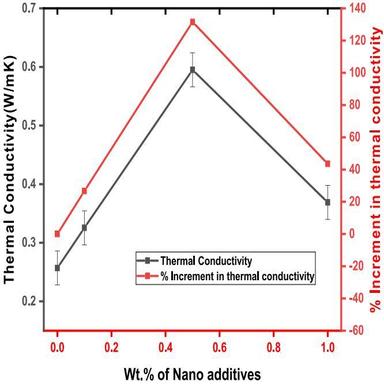
Thermal conductivity of composites at room temperature.